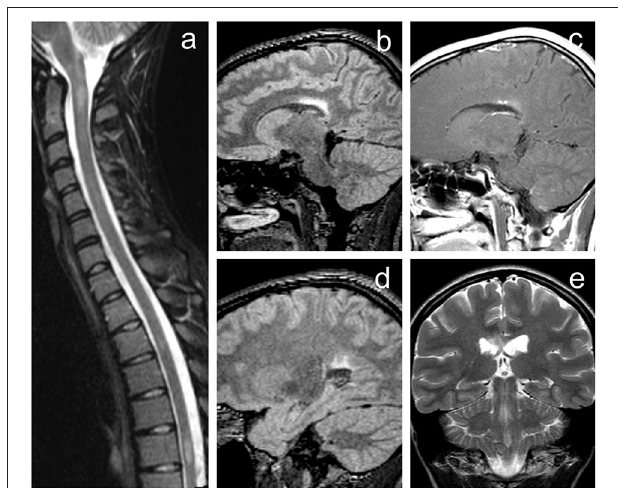
FIGURE 1 | Initial MRI of the brain demonstrating rather typical finding of demyelinating disease fulfilling McDonald diagnostic criteria for multiple sclerosis. (a) Short-tau inversion recovery (STIR) image of the cervical and upper thoracic spine in sagittal plane revealing several hyperintense lesions (level C1/2, Th3/4, and Th6). (b,d) 3D fluid-attenuated inversion recovery (FLAIR) images of the brain in the sagittal plane. (e) T2-weighted image in the coronal plane. (c) Contrast-enhanced T1-weighted image with magnetization transfer in sagittal plane. Brain MRI revealed several periventricular white matter lesions including the largest FLAIR hyperintense plaque within the corpus callosum (b,e) with punctate enhancement (c) . Image (d) shows some of the other smaller lesions near the trigone of the left lateral ventricle.